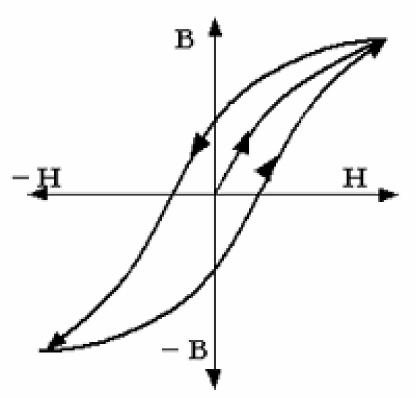
Figure 2. Hysteresis loop